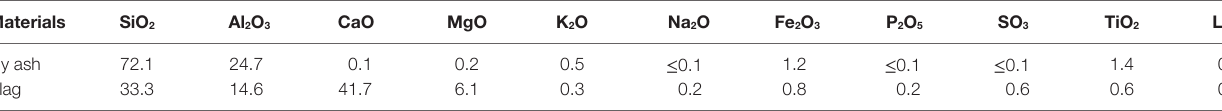
Table 1 | compositions of solid raw materials, mass%.